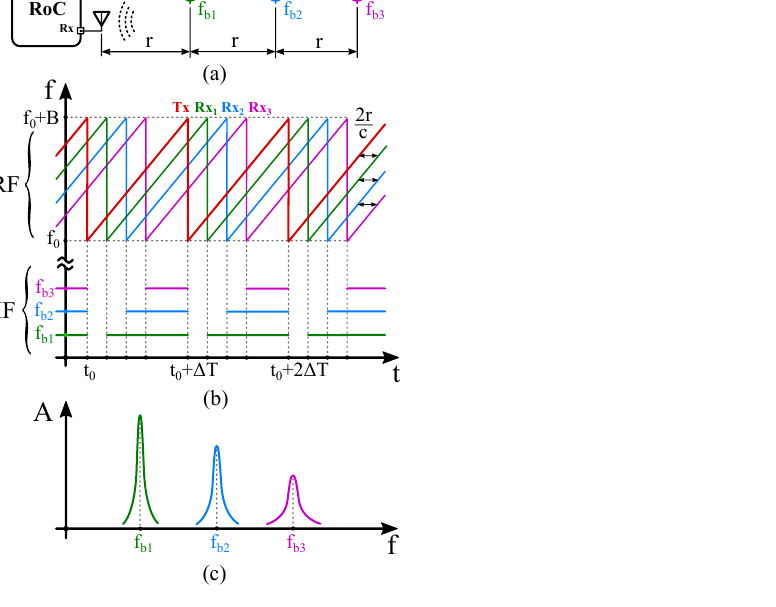
Figure 3. Illustrations showing the principle of distance estimation for a conventional FMCW auto- motive Radar-on-Chip (RoC): ( a ) equidistant spatial object positioning, ( b ) time-domain transmitted (TX) and received (RX 1 , RX 2 , and RX 3 ) reflected up-chirps with the corresponding mixing products ( f b 1 , f b 2 , and f b 3 ), and ( c ) the magnitude spectrum of intermediate-frequency signal.